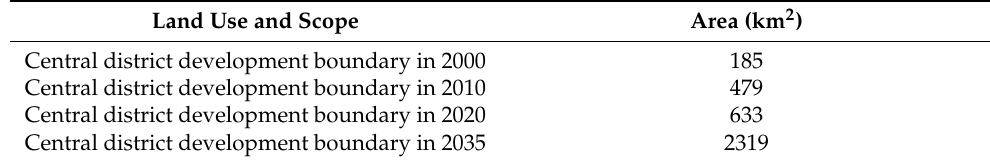
Table 8. Area of the central district boundary before